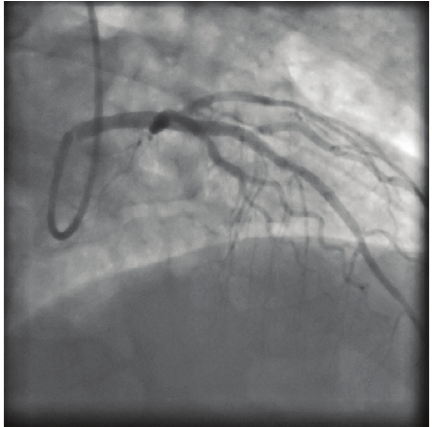
Figure 2: Good angiographic result with TIMI 3 flow following di- rect stenting of